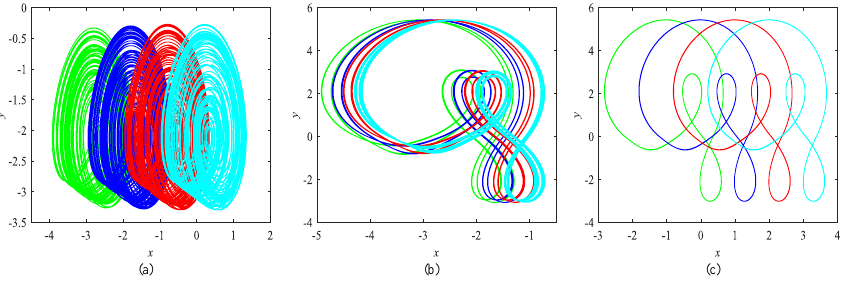
Figure 16. Offset boosting with control parameter p . ( a ) p = 3, 2, 1, 0; ( b ) p = − 1, − 1.2, − 1.4, − 1.6; ( c ) p = − 3, − 4, − 5, −